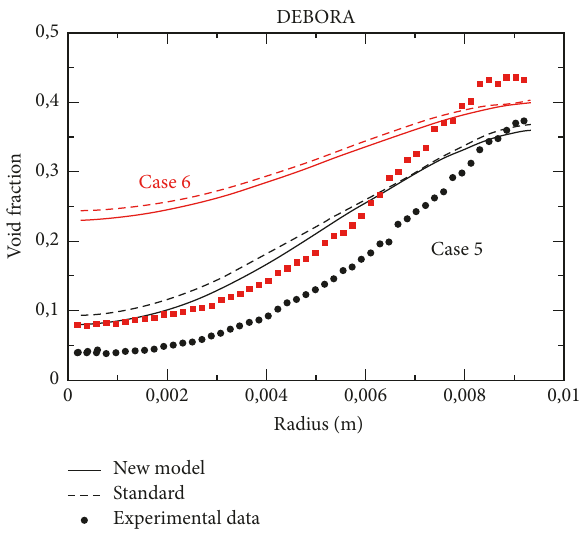
Figure 52: Void fraction, comparison of the new and the previous model for cases 5 (black) and 6 (red).